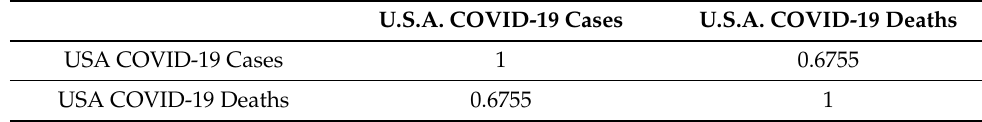
Table 3. Correlation matrix U.S.A. COVID-19 cases and deaths.